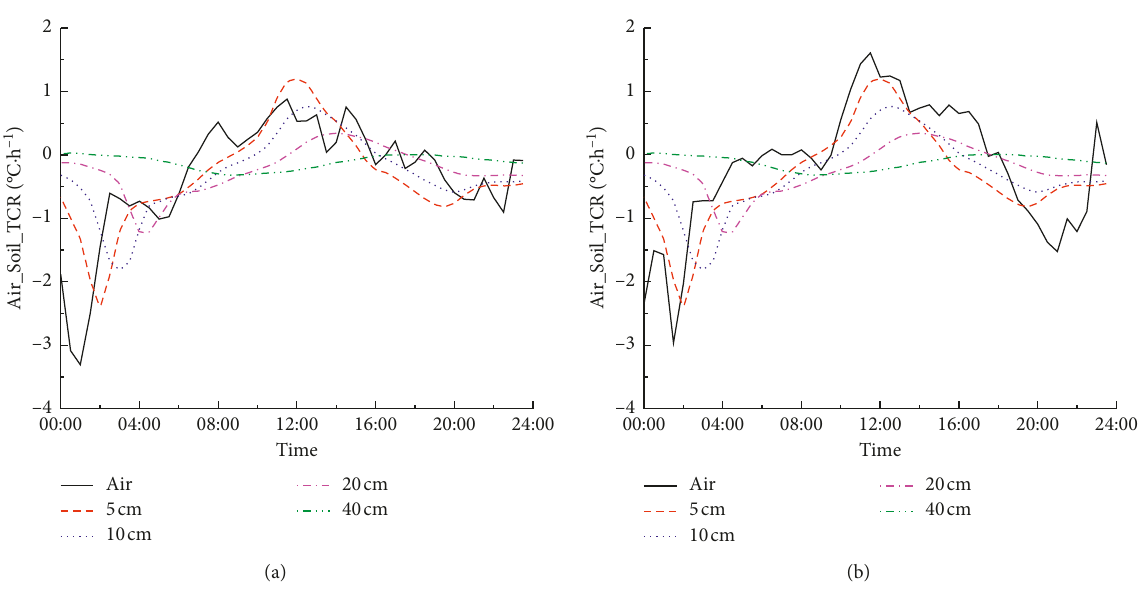
Figure 4: Diurnal TCR variation in the air and in each layer: (a) rainy days and (b) clear days.